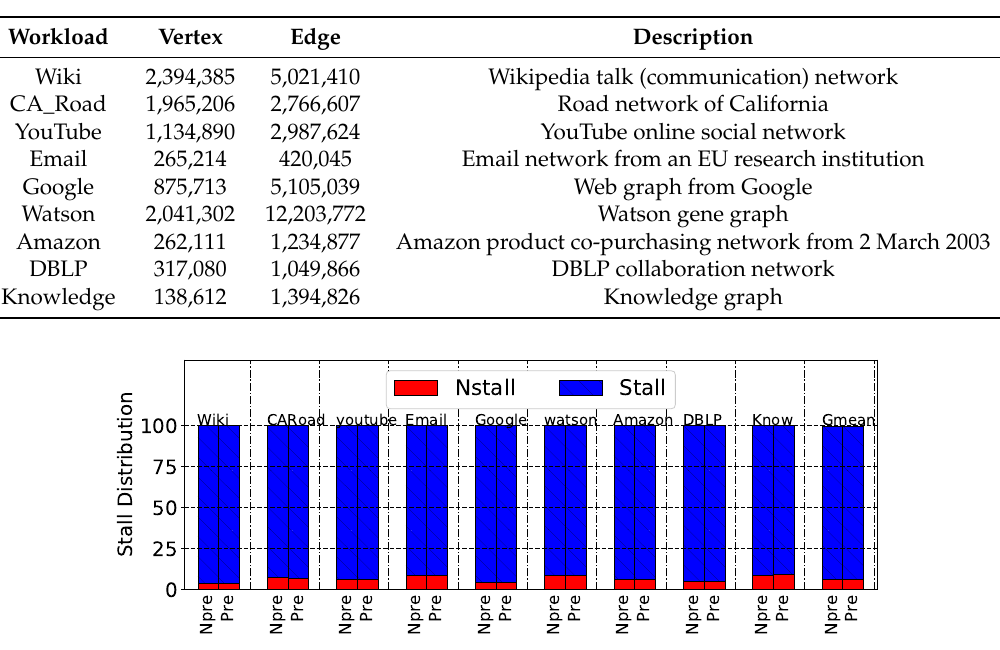
Figure 4. Stall ratio of graph traversal benchmarks without prefetch ( N_Pref ) and with stream prefetch ( Pref ).